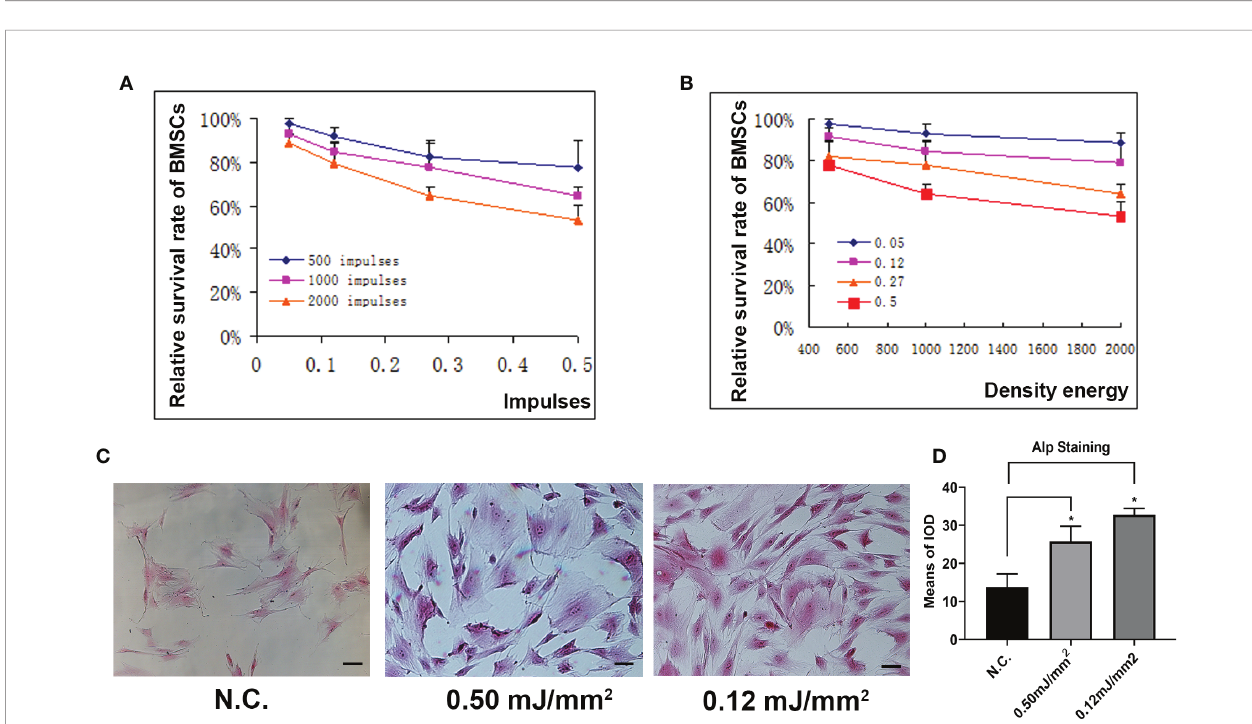
FIGURE 3 | Different density or frequency of energy had little effects on osteogenesis. (A) Relative survival rate of BMSCs treated with ESW at different impulses. (B) Relative survival rate of BMSCs treated with ESW at different density of energy. (C) Representative images of ALP staining in BMSCs treated with ESW at different density of energy and quantitative analysis (D) Scale bar: 100 m m. Data are reported as the mean ± SD. *p < 0.05.